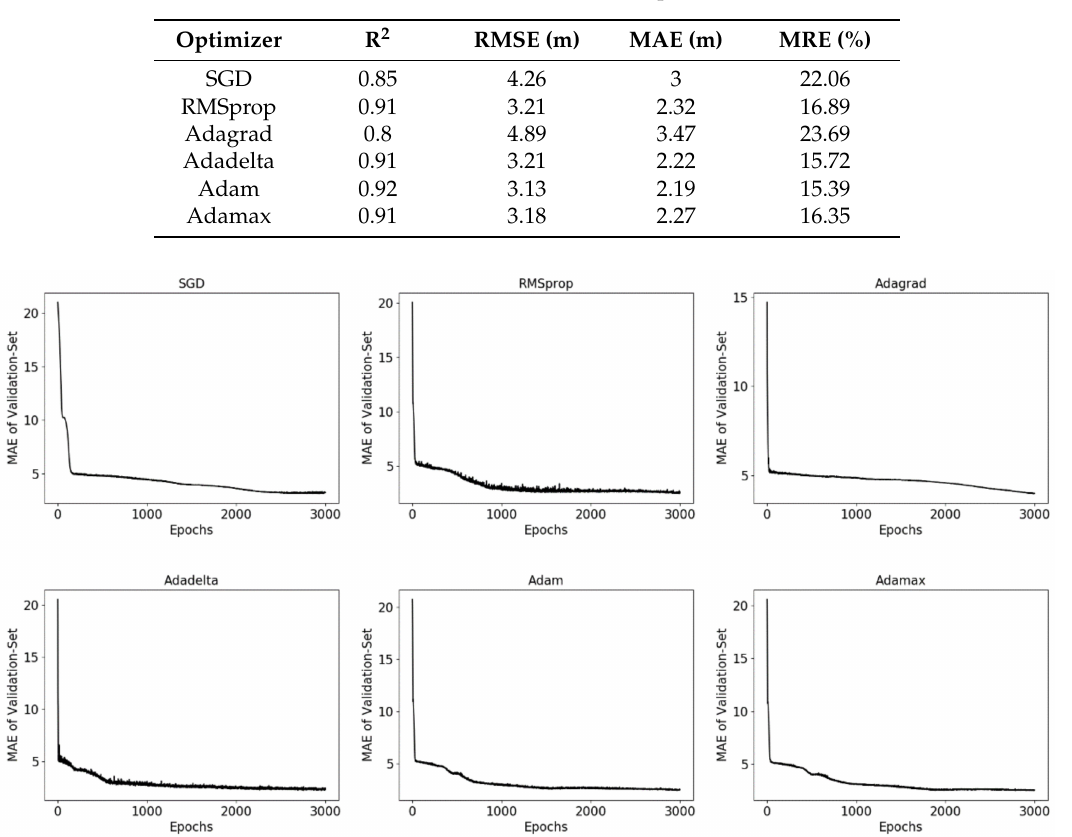
Figure 11. Change trend of